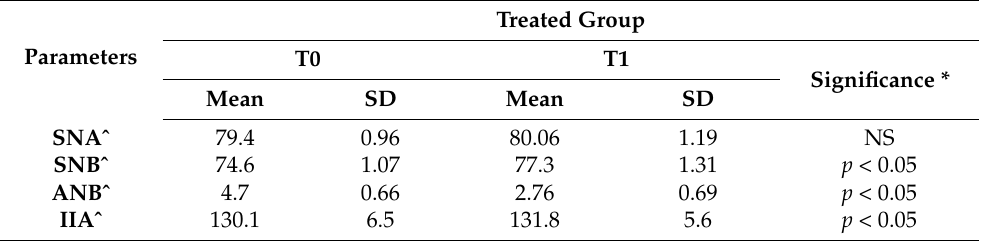
Table 4. Inferential statistics of overjet and overbite detected within treated and control groups. T0 = pre-treatment, T1 = post-treatment, SD = standard deviation; * = significance set at p < 0.05 and based on paired Student’s t -test for inter-timing